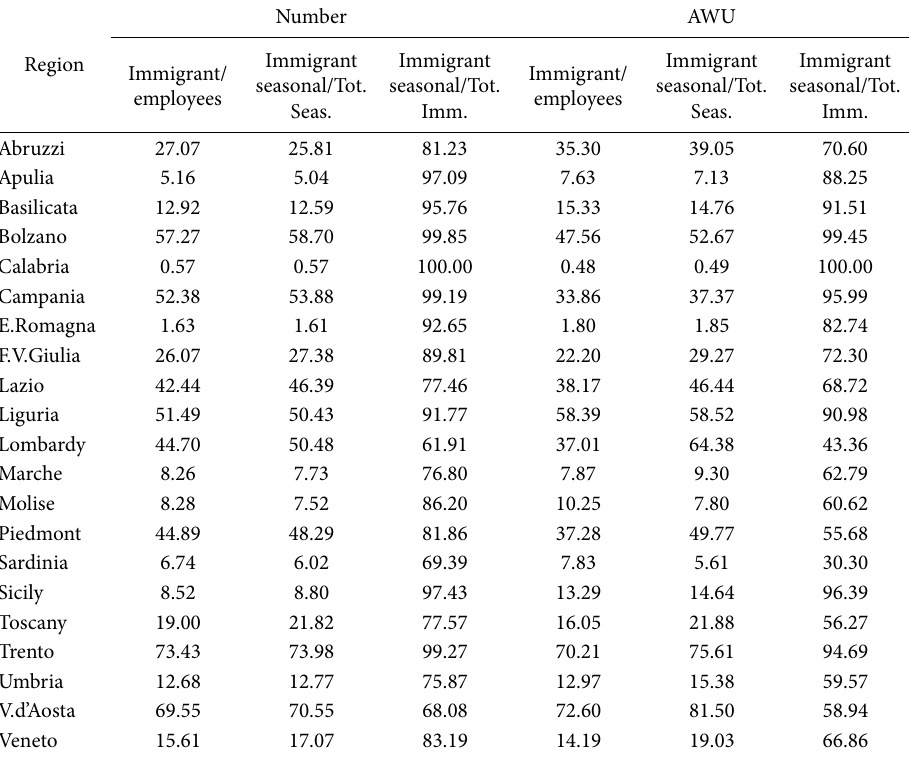
Table 5. Shares of immigrants by region and type of contract. Italian FADN sample 2008-2015. Number AWU Immigrant Immigrant Immigrant Region Immigrant/ Immigrant/ seasonal/Tot. seasonal/Tot. seasonal/Tot. employees employees Seas. Imm.